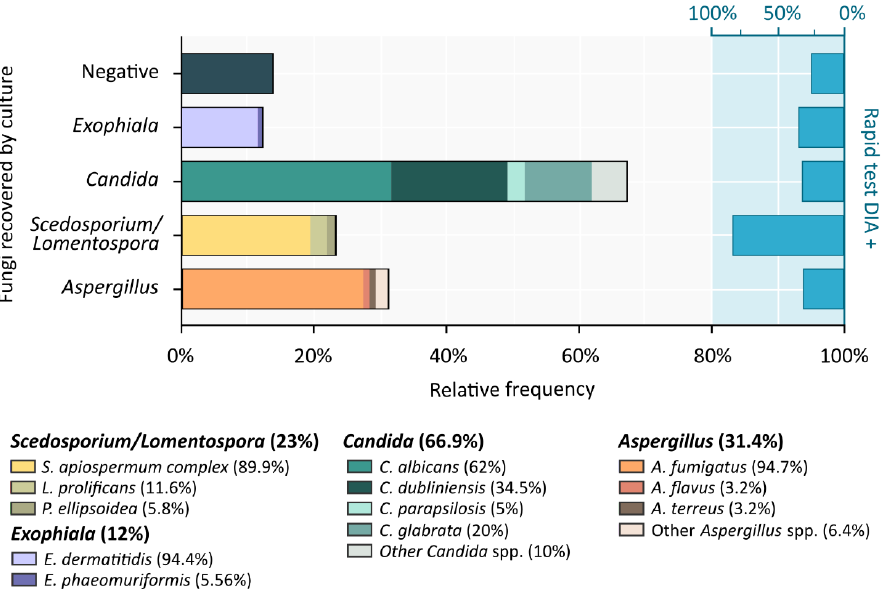
Figure 4. Frequency of isolation of fungal species from respiratory samples and anti- Scedosporium / Lomentospora IgG prevalence. Left y-axis and lower x-axis: relative frequencies of fungi recovered from culture of 299 sputum samples corresponding to CF patients ’ tested sera. Right y-axis and upper x-axis: prevalence rates for each fungal group of anti- Scedosporium / Lomentospora IgGs present in serum assessed with DIA rapid test.